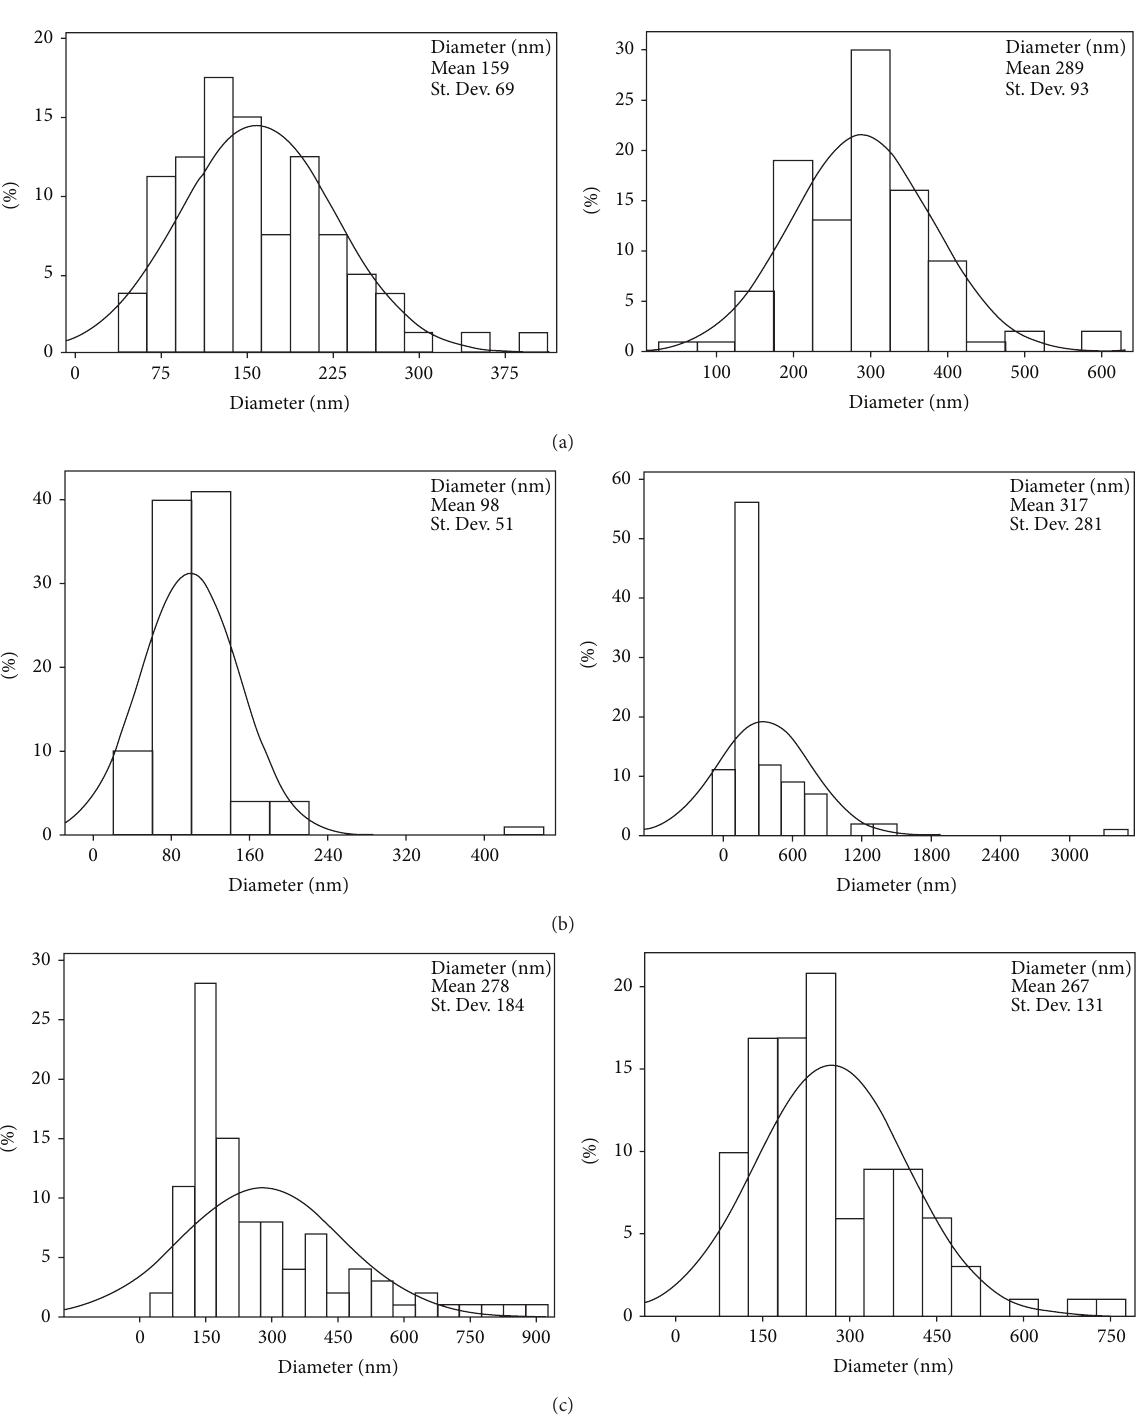
Figure 4: Diameter histograms of spun fibers obtained by solution blow spinning and electrospinning for PLA (a), PCL (b), and PEO (c). Right side: electrospun and left: